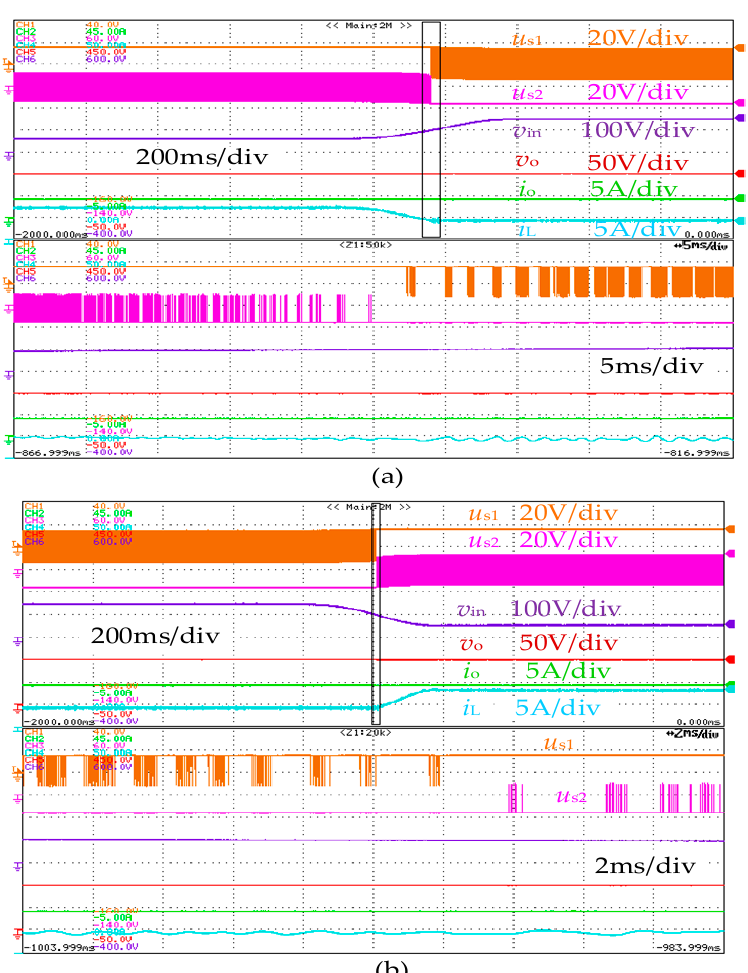
Figure 10. Experiment results of work mode transition: ( a ) from boost mode to buck mode and ( b ) from buck mode to boost mode.